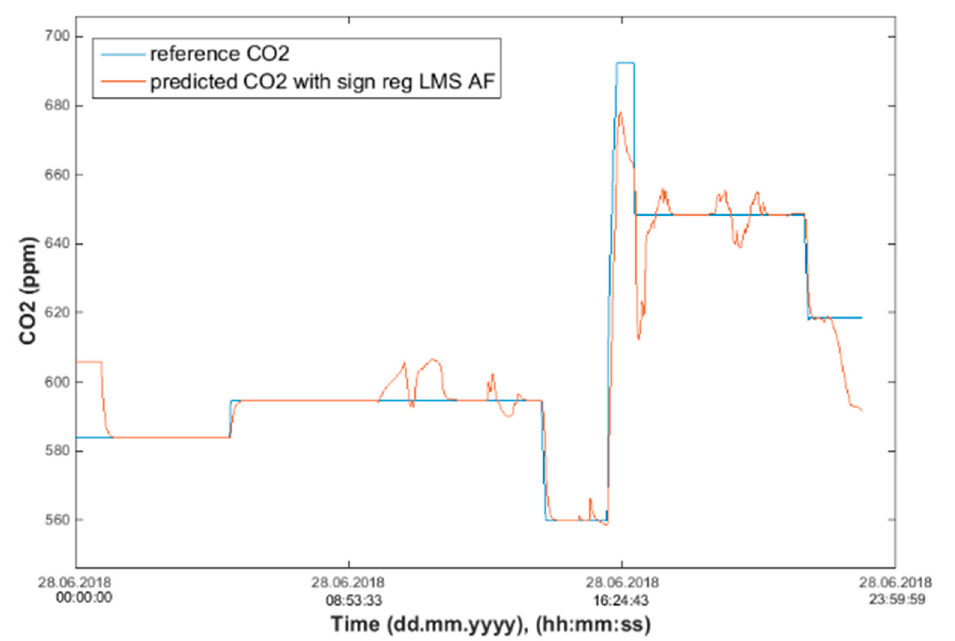
Figure 28. Comparison of the reference and predicted CO 2 waveforms (SRLMS AF) from 28 June 2018 in R204 with an ANN with 90 neurons and SCG method trained with data from 25 June 2018 in R203.